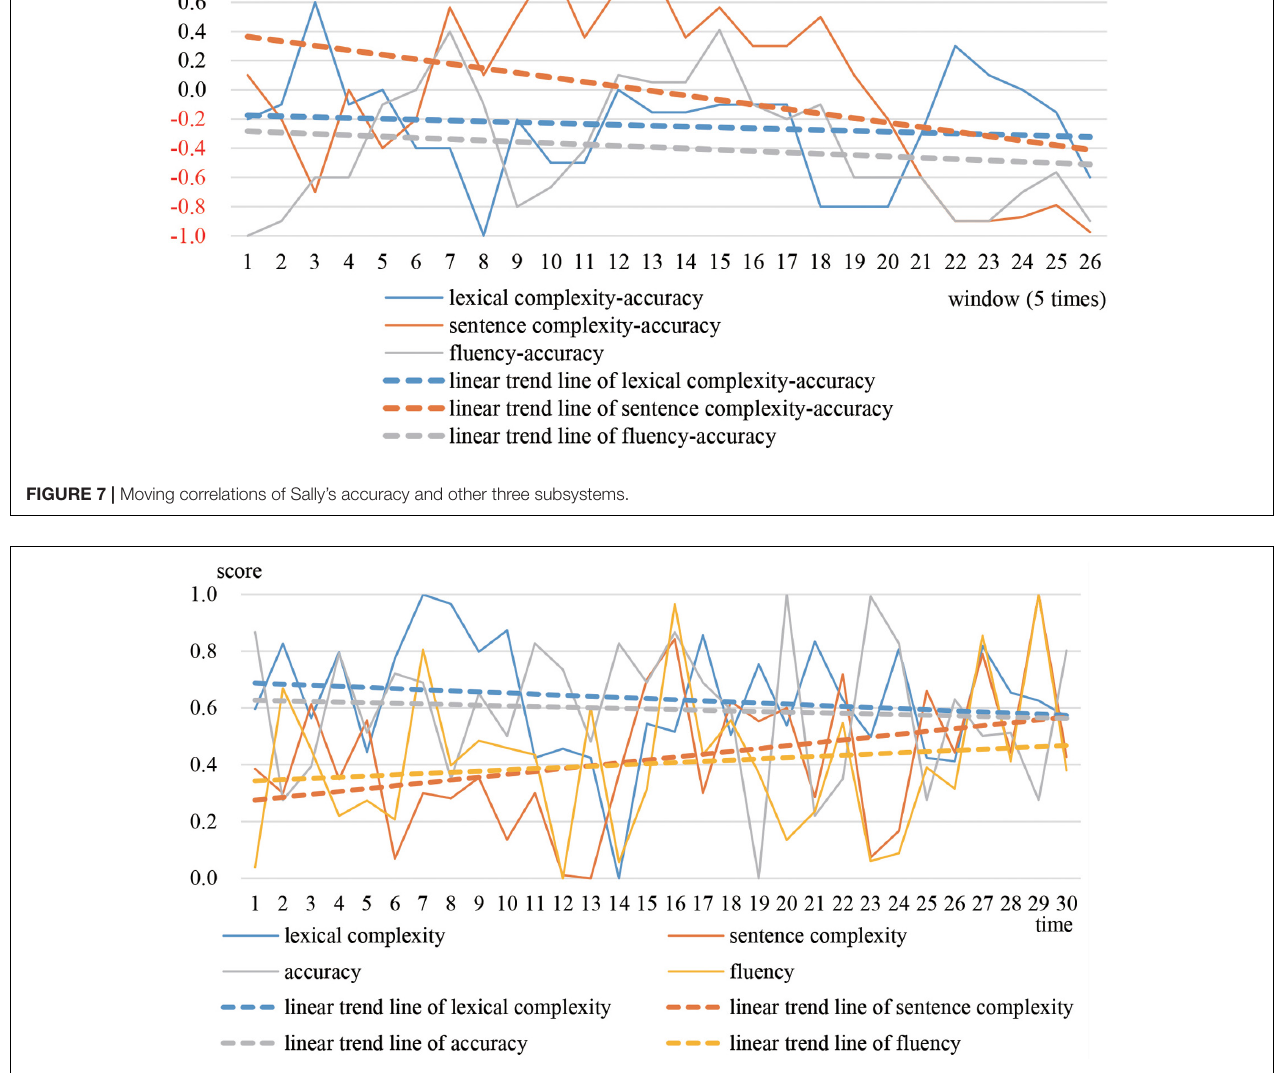
FIGURE 8 | Developmental trajectories and trends of Sally’s